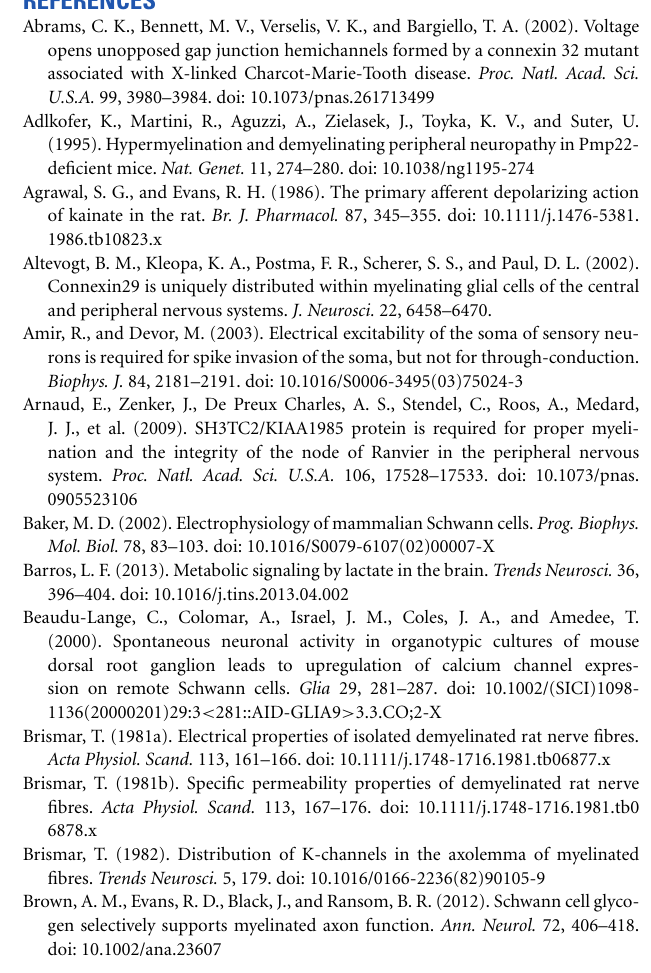
Table S1 | Transcriptional regulation of genes encoding potential SC-to-neuron support molecules in mouse models of peripheral neuropathies. Re-analyzed microarray data were originally generated by characterization of endoneurial samples from adult, 56 days-old Scap , Lpin1 , and Pmp22 knockout mice. The grouping in the categories of “Metabolism” and “Vesicle trafficking” was based on Gene Ontology, whereas grouping in the “Exosome-exocytic vesicle cargo” category was performed by manual annotation based on (Lopez-Verrilli and Court, 2012; Fruhbeis et al., 2013). For more information regarding the experiments and data analysis, see legend of Table 1 and (Verdier et al., 2012). Asterisk ( ∗ ) indicates transcripts that have been previously described in axons of DRG neurons (Willis et al., 2007; Gumy et al.,